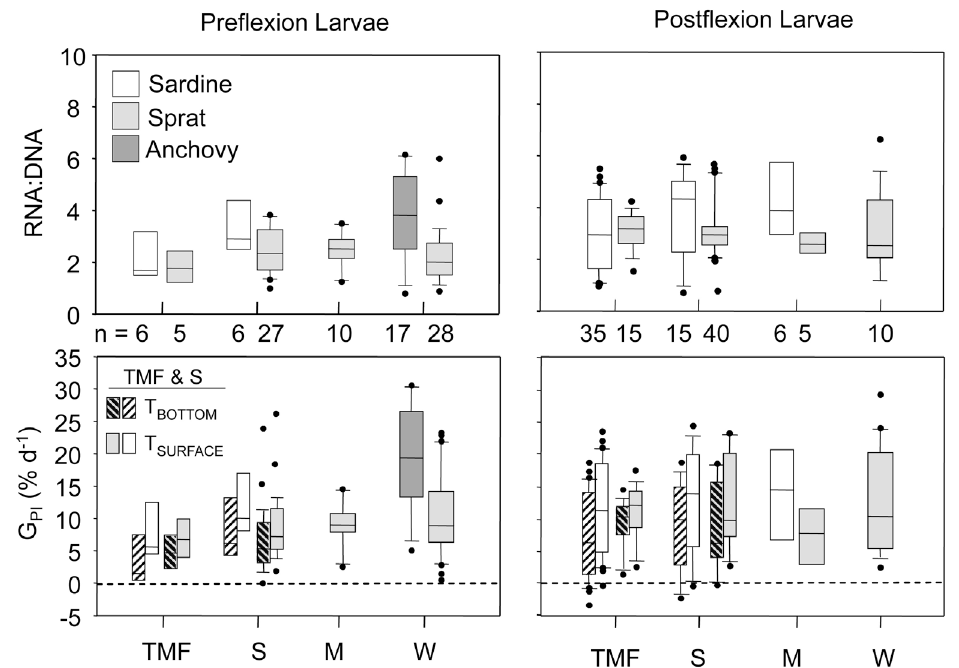
F IG . 6. – Box and whisker plots of values of RNA:DNA and protein-specific growth rate ( G ) for pre-and post-flexion clupeiform lar- PI vae collected in each of four different habitats (tidal mixing front (TMF), stratified (Strat.), mixed (Mixed), and Wadden Sea. For sprat and sardine sampled in frontal and stratified areas, minimum (light grey) and maximum G (calculated based upon minimum PI and maximum water temperatures that could have been experienced at each station) are shown (sprat, white background; sardine, grey background). The median, 10th, 25th 75th and 90th percentiles and outliers are indicated. The number of larvae analysed is shown between top and bottom